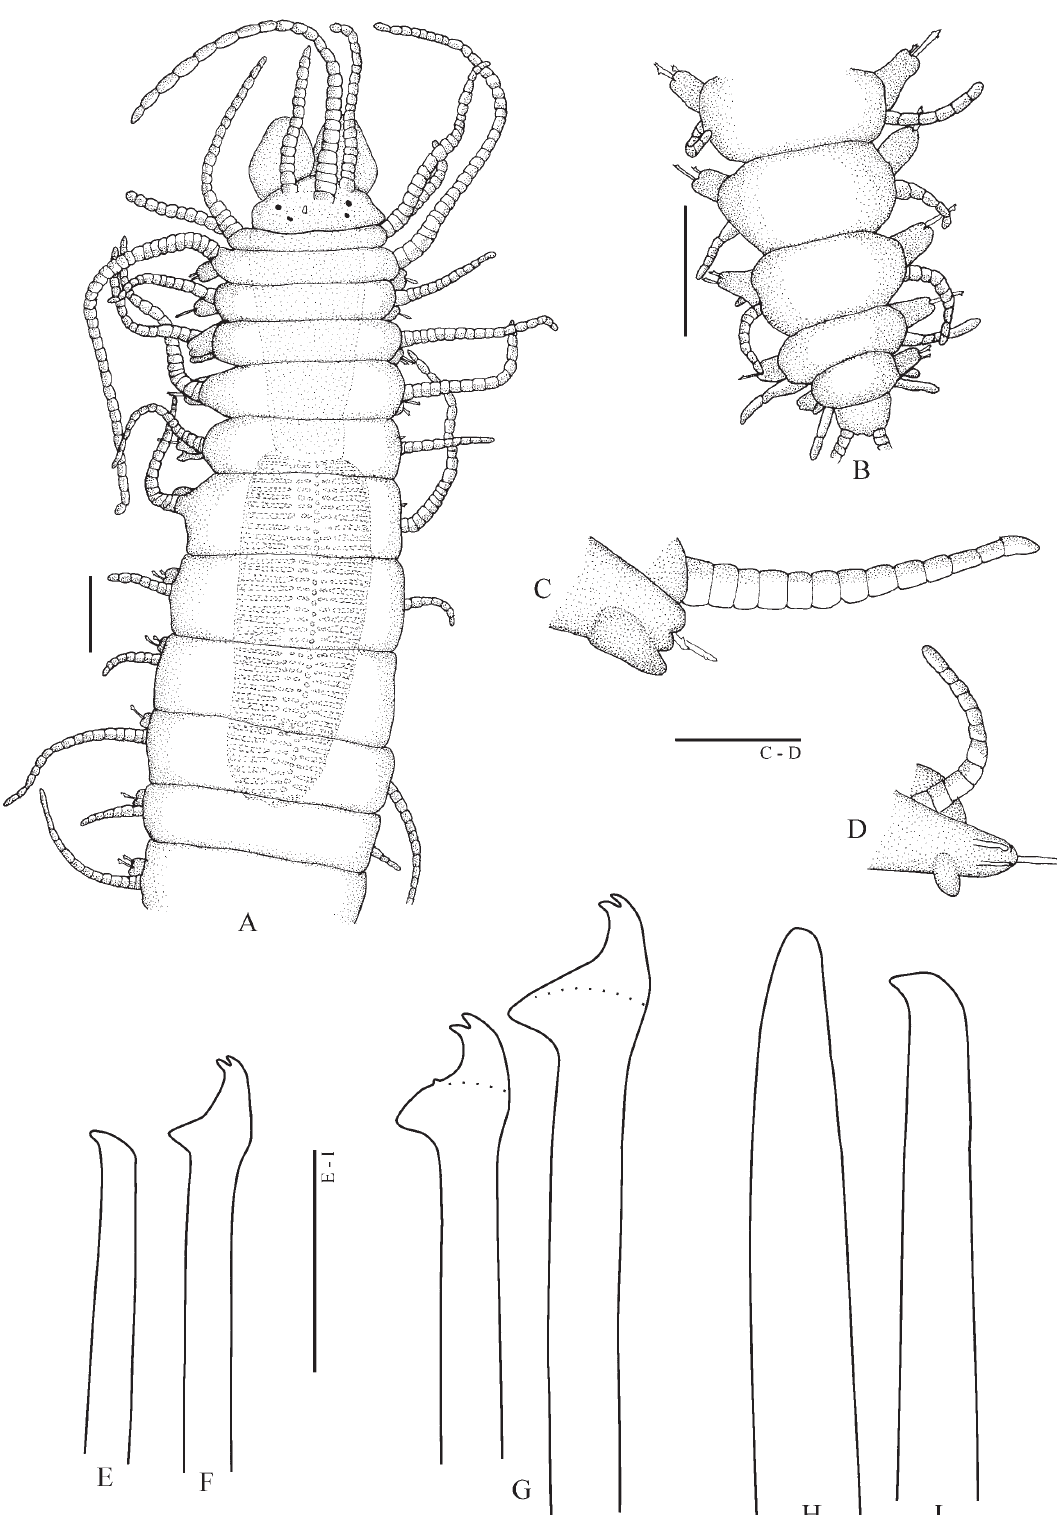
Fig . 9. – Hand-drawing of Haplosyllis chaetafusorata n. sp. A, anterior end, dorsal view. B, posterior end, dorsal view. C, anterior parapo- dium, chaetiger 2. D, posterior parapodium, last third chaetiger. E, anterior acicula, chaetiger 5. F, anterior chaeta, chaetiger 3. G, mid-body chaetae with traces of fusion between blade and shaft. H, mid-body straight acicula. I, mid-body acicula with curved tip. Scale bars: A-B (200 m m), C-D (100 m m), E-I (20 m m). INV-ANE